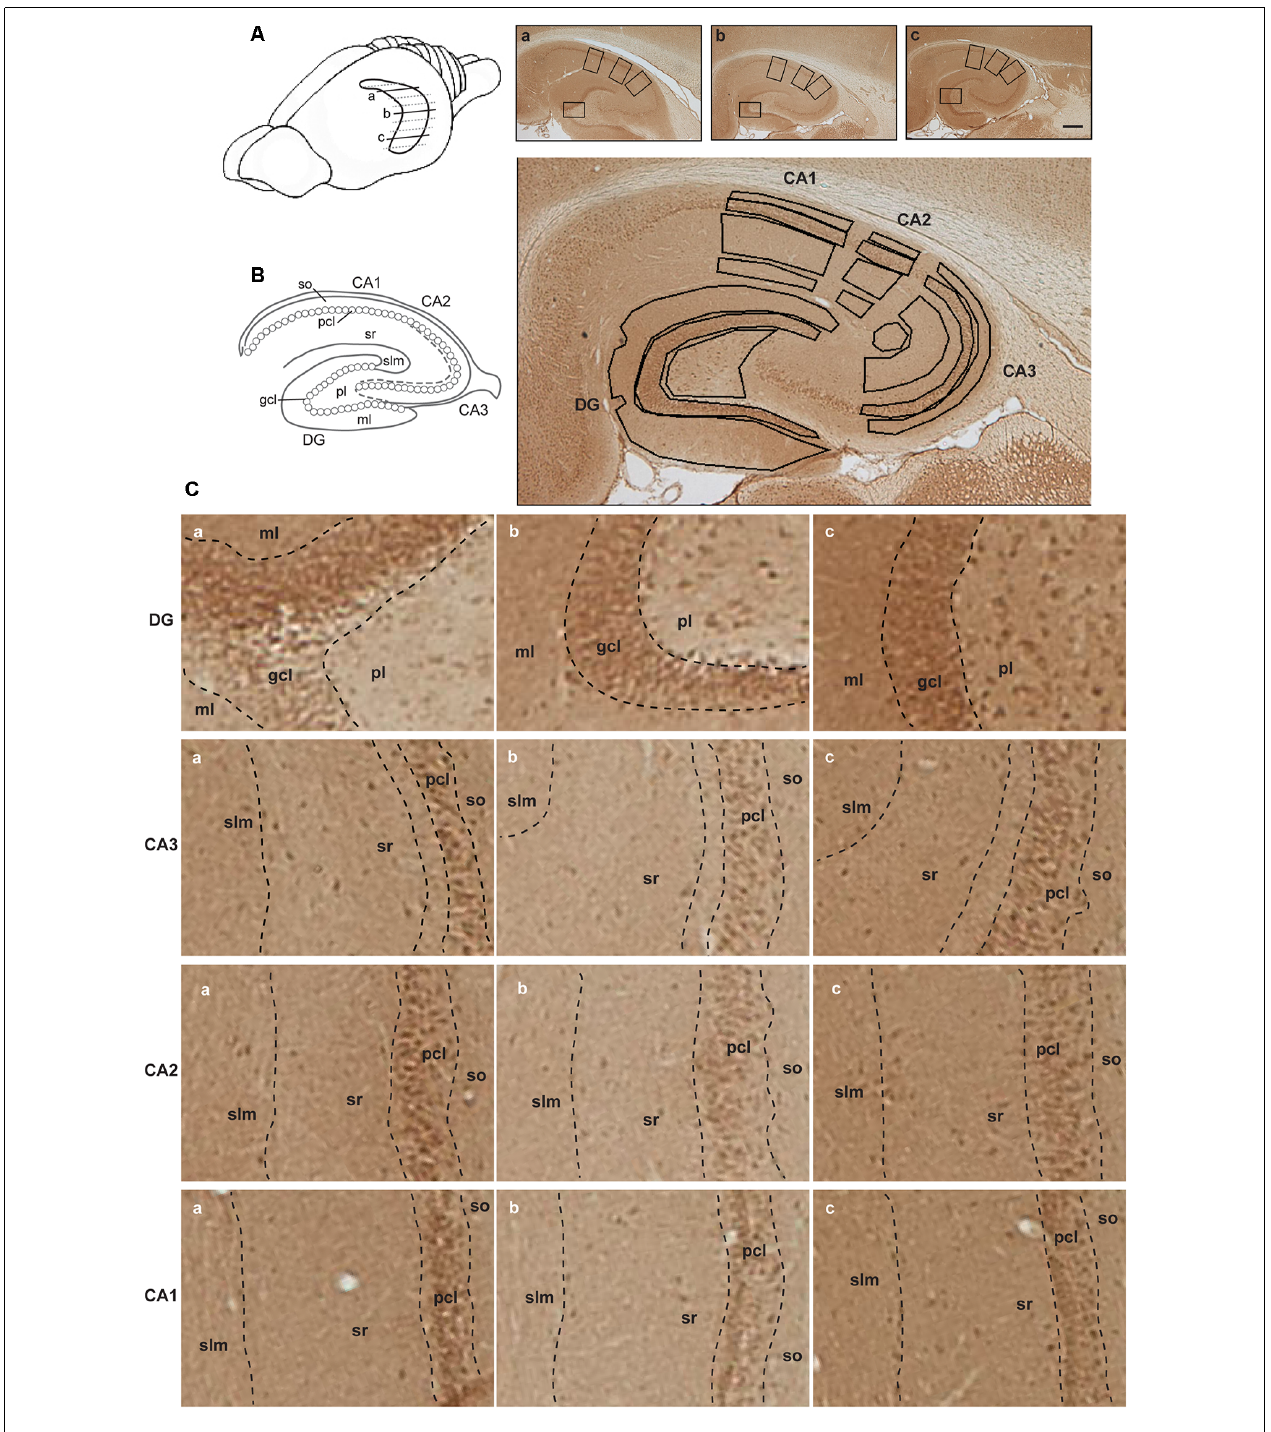
FIGURE 2 | Illustration of hippocampal separation into longitudinal and transverse axes. (A) A drawing of the rat brain with horizontally sectioned hippocampus is presented. Representative images of immunohistochemically stained sections against D2R of the dorsal (a), intermediate (b) and ventral hippocampus (c) from the same animal are shown. Scale bar is 500 µ m. Squares on each image correspond to zoom-in fragments on the panel (C) . (B) Schematic representation of the hippocampal transverse axis and laminar separation (left). Immunohistochemically stained section with marked regions taken for the analysis is depicted (right). Abbreviations correspond to: ml, molecular layer of the DG; gcl, granule cell layer of the DG; pl, polymorphic layer of the DG; so, Stratum oriens of CA3/CA2/CA1; pcl, pyramidal cell layer of CA3/CA2/CA1; sr, Stratum radiatum of CA3/CA2/CA1; and slm, Stratum lacunosum-moleculare of CA3/CA2/CA1. (C) A closer view of subsections of the dentate gyrus (DG) and CA regions from the dorsal (a), intermediate (b) and ventral (c) hippocampal sections, including the laminar delineation, is shown.